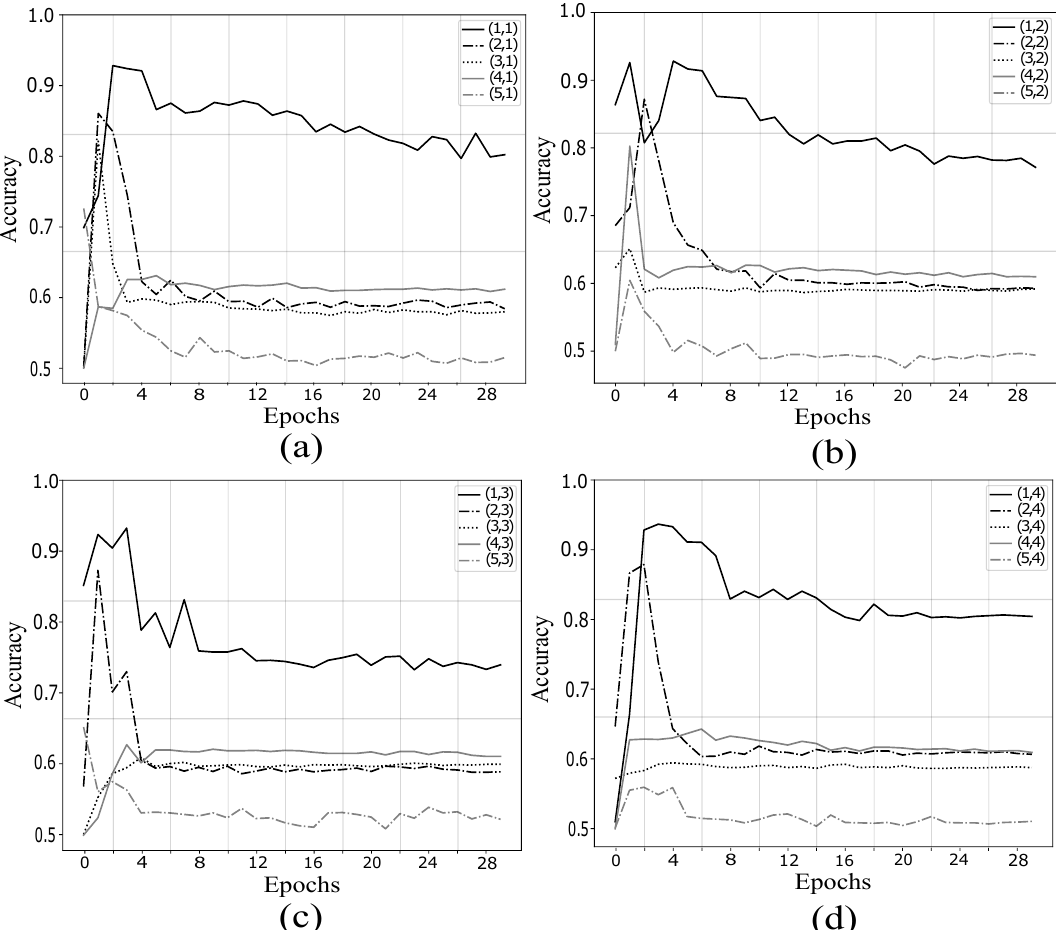
Figure 8. Analysis of kernel size in second convolutional layer: ( a ) (j,1); ( b ) (j,2); ( c ) (j,3); and ( d ) (j,4). The kernel size (1,1) in ( a ) presented less overfitting and major classification accuracy. The only y -axis where the CNN can achieve a stable accuracy throughout the epochs is